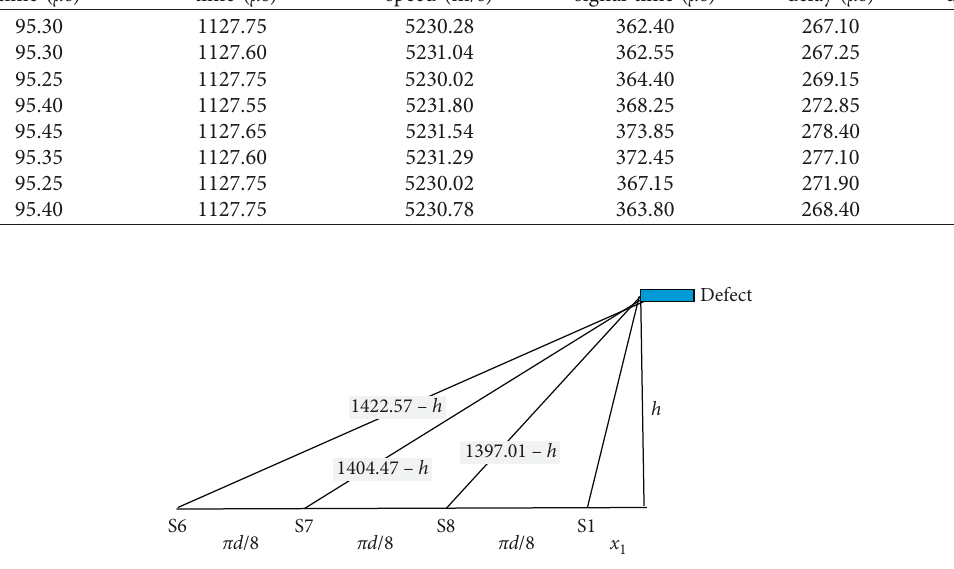
Figure 25: Guided wave propagation distances.